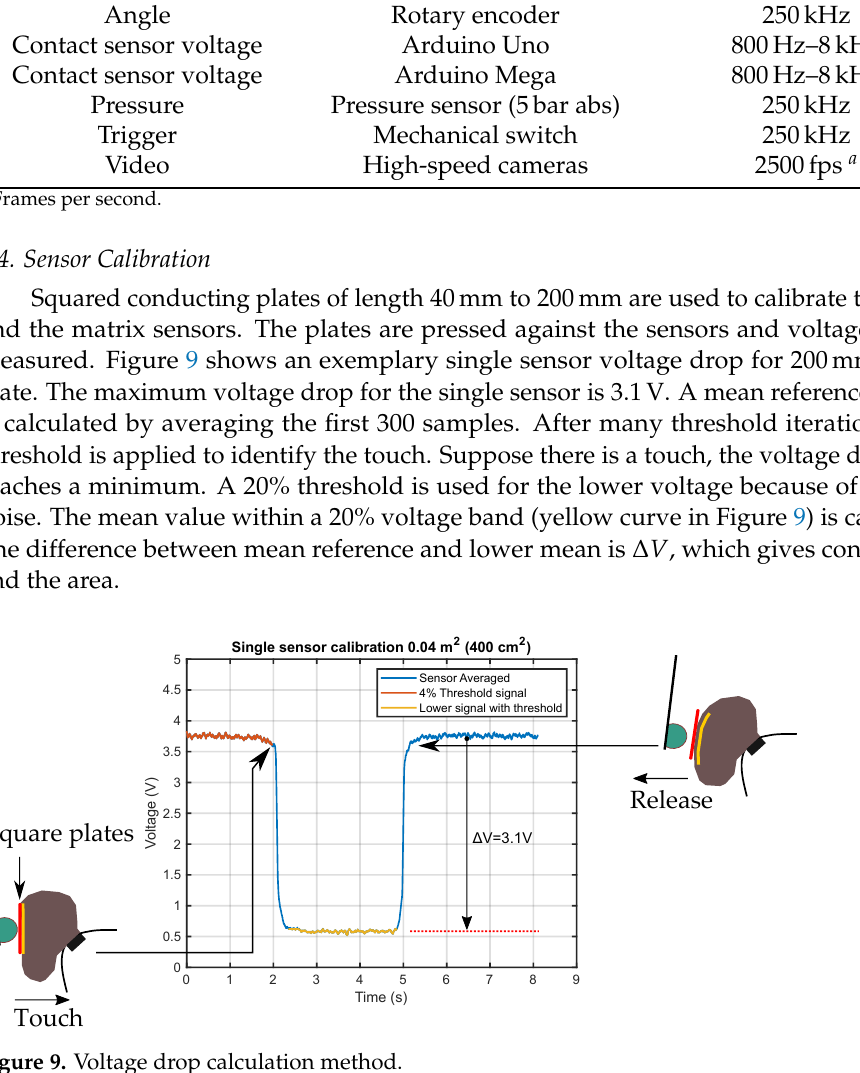
Figure 9. Voltage drop calculation